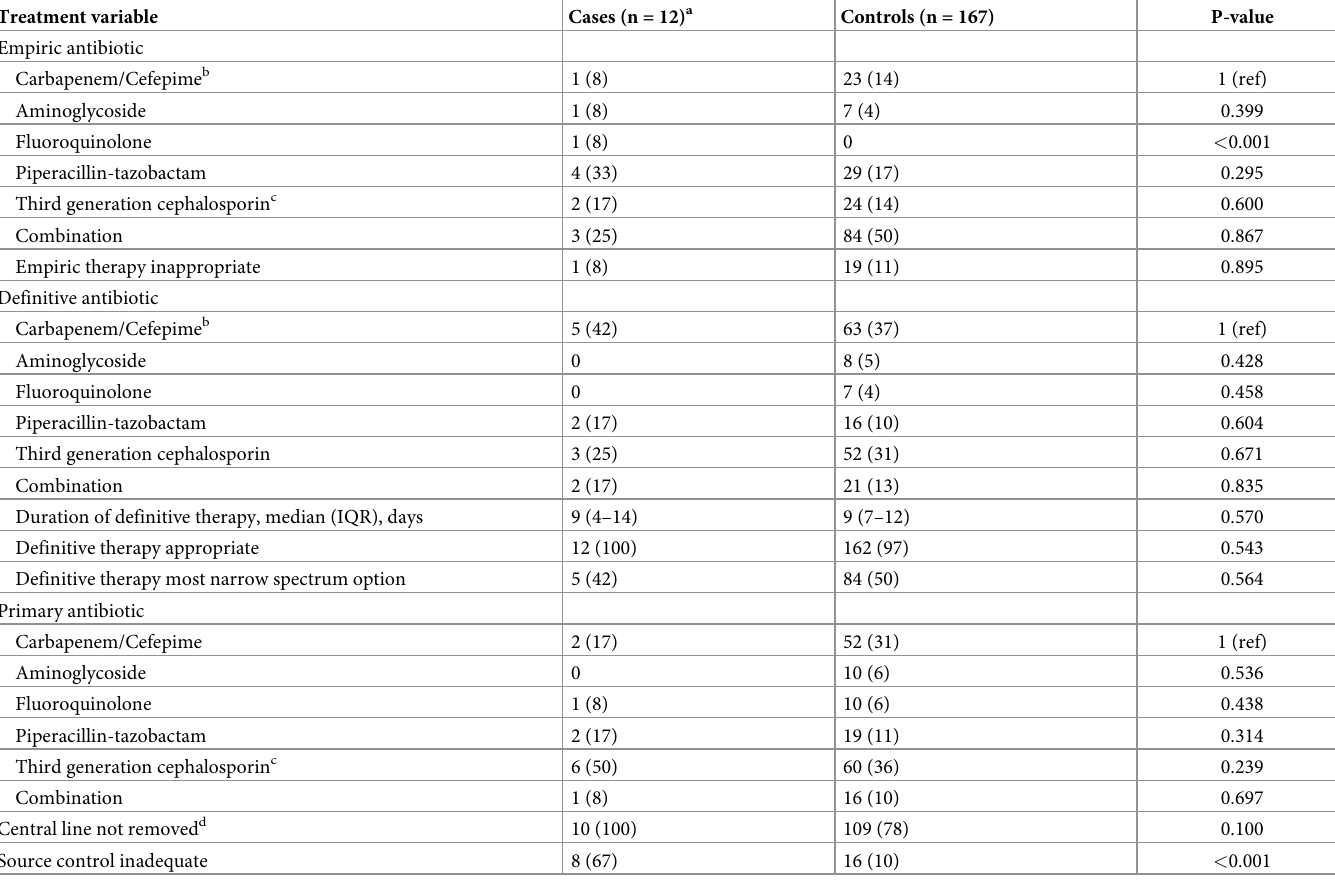
Table 2. Treatment regimens and